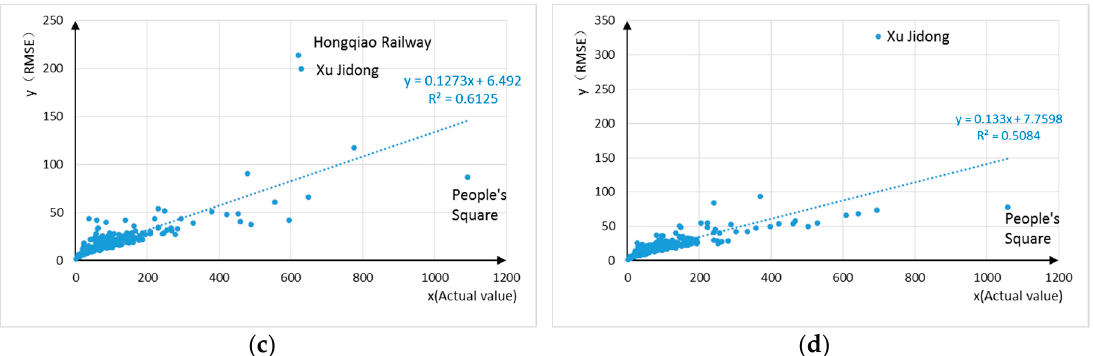
Figure 15. The relationship between the RMSE and SMAV of ( a ) passenger inflow volume at each station on working days, ( b ) passenger outflow volume at each station on working days, ( c ) passenger inflow volume at each station on non-working days, and ( d ) passenger outflow volume at each station on non-working days.